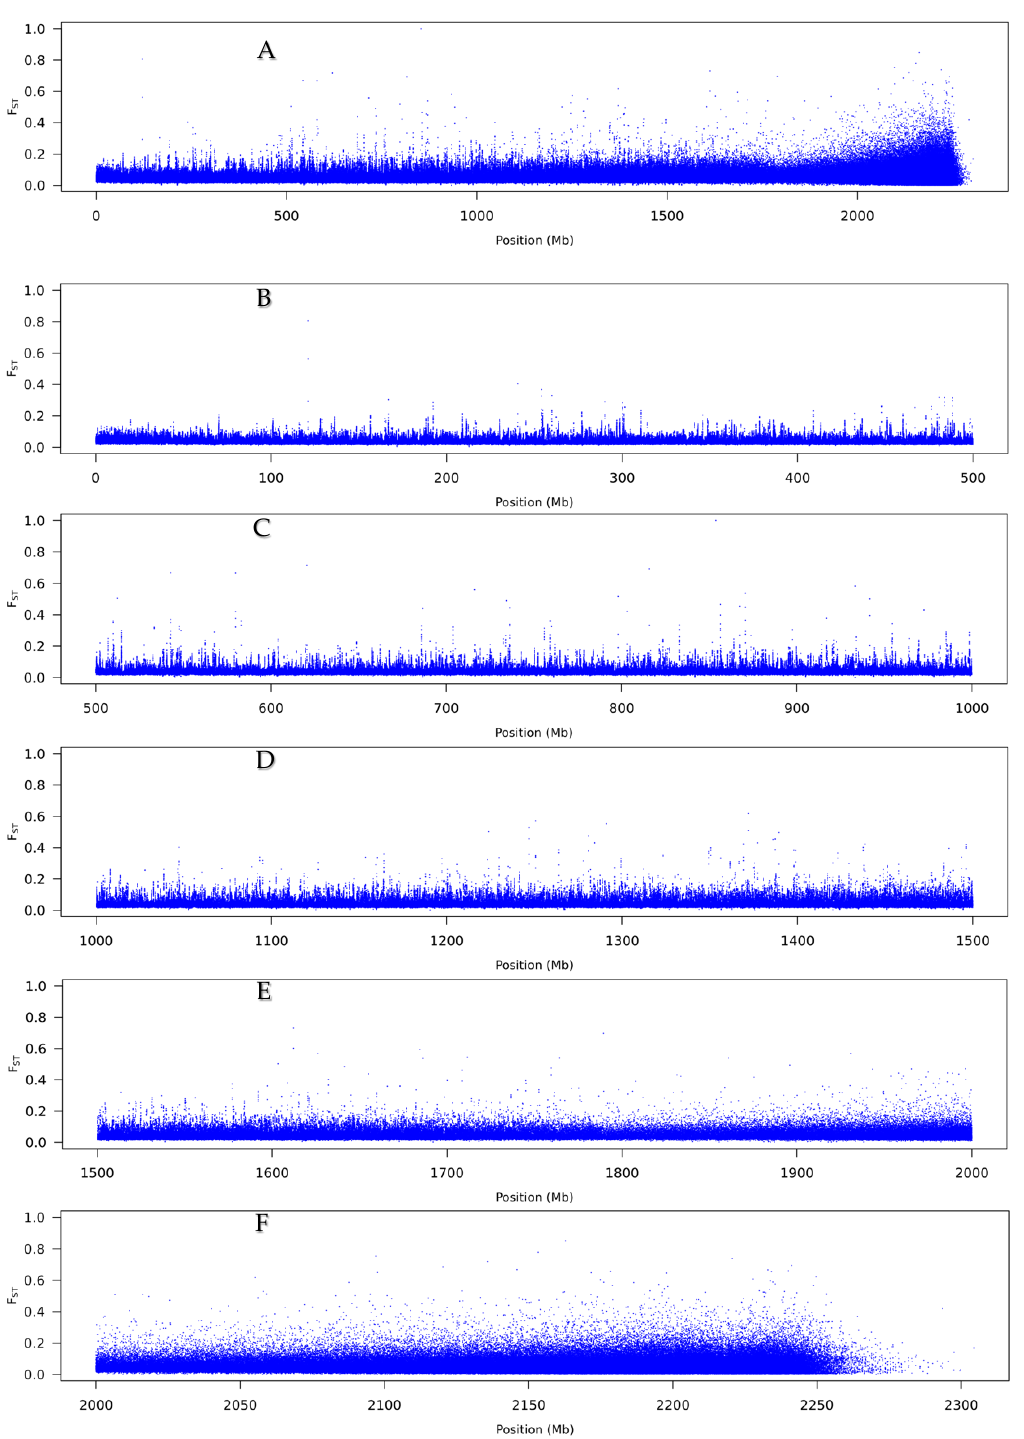
Figure 7. F ST summary from the comparison of the pools of anaflexistylous and cataflexistylous individuals of Alpinia nigra , for window sizes of 10 kbp and step sizes of 1 kbp. ( A ) Genome-wide F ST scan, ( B ) scan across the first 500 Mbp, ( C ) scan from 500 to 1000 Mbp, ( D ) scan from 1000 to 1500 Mbp, ( E ) scan from 1500 to 2000 Mbp and ( F ) scan from 2000 Mbp to end. The scaffolds are ordered by length starting from the largest.